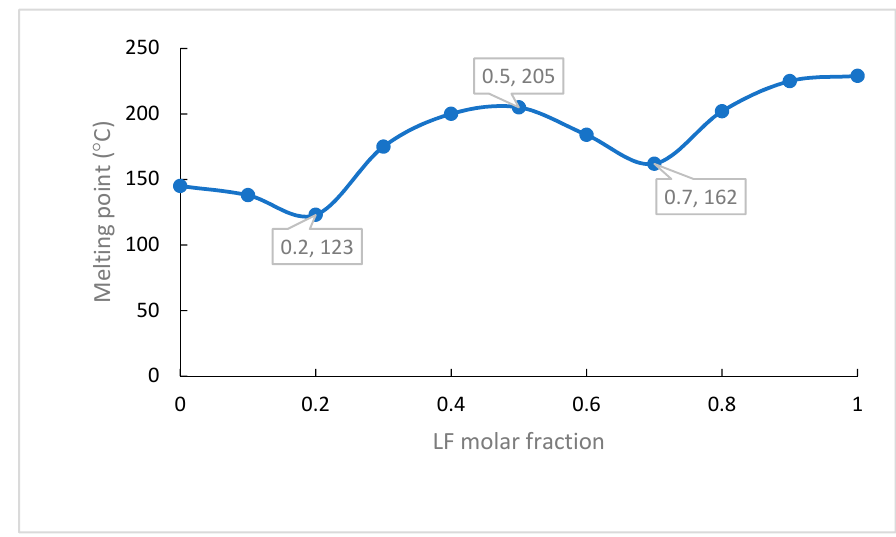
Figure 2. Phase diagram of LF-CA binary system.